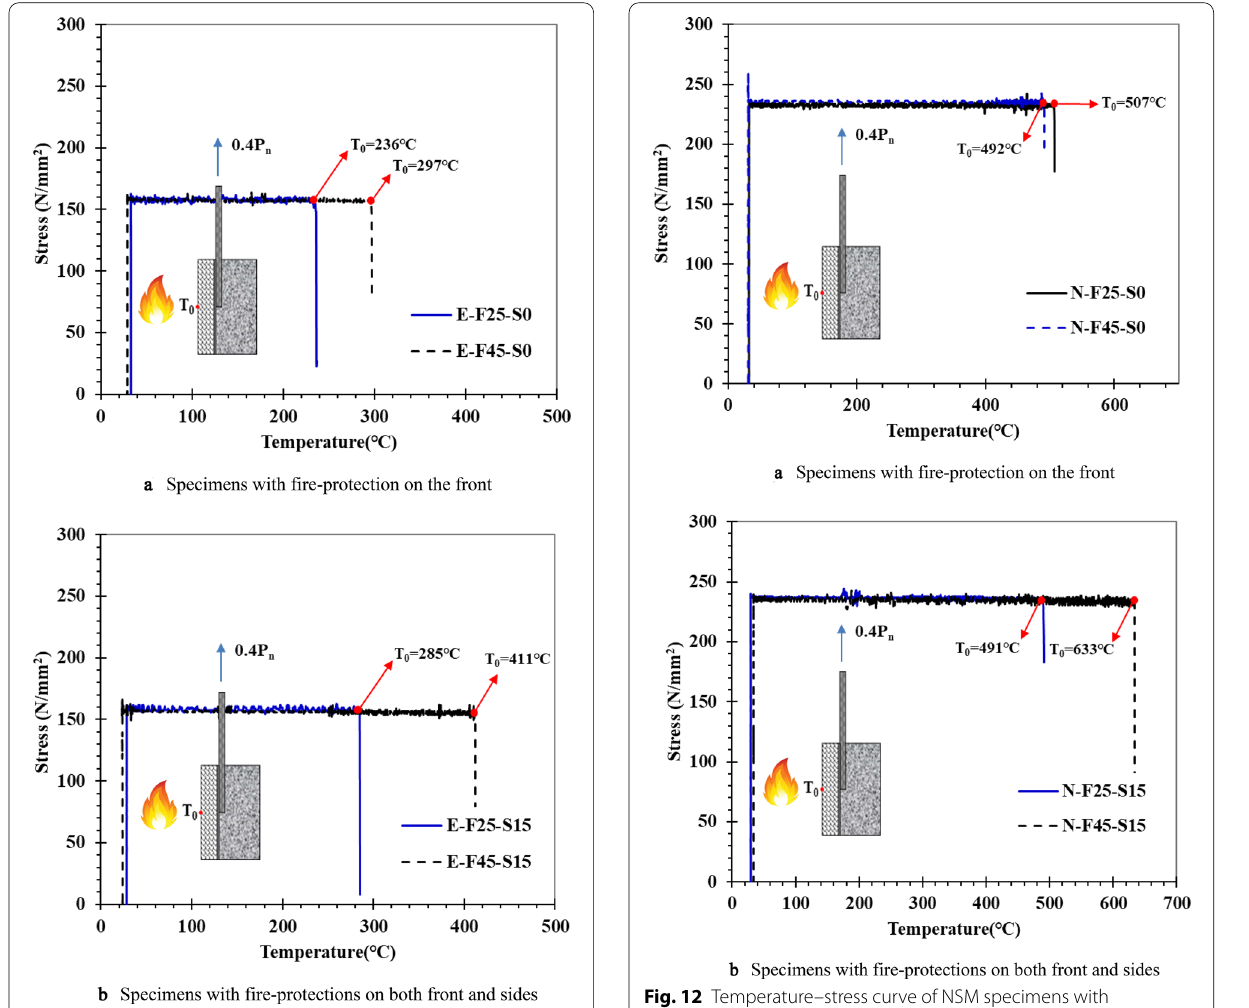
Fig. 11 Temperature–stress curve of EB specimens with fire‑protection.